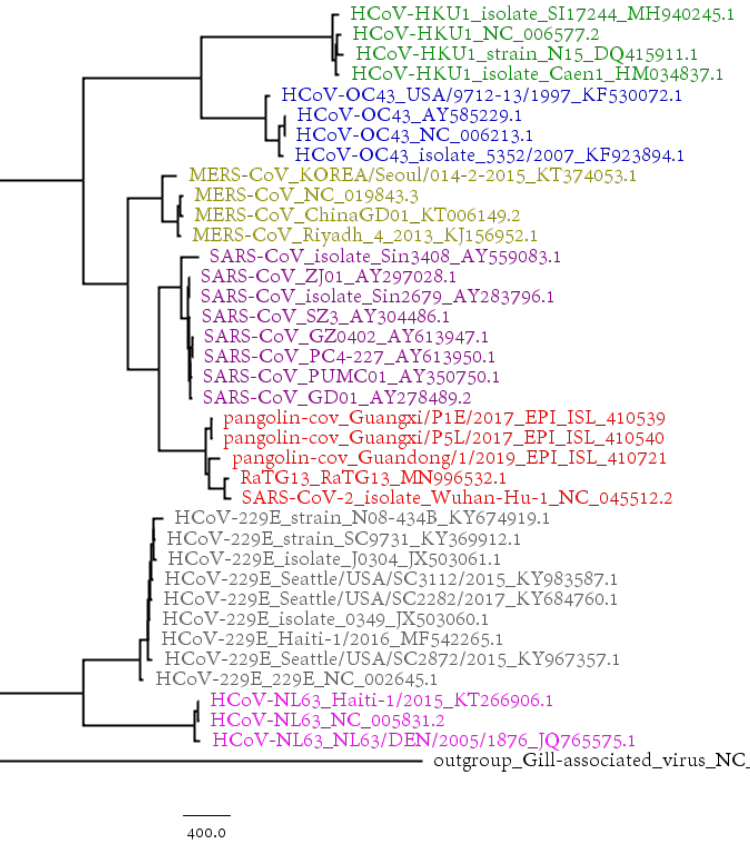
Figure 3. The phylogenetic tree of 38 coronavirus genomes based on BioNJ and Natural Vector algorithm. Table 1. The RMSD and NV distance between 3CL proteinase (6LU7) / spike protein (6VXX) of SARS-CoV-2 and the counterpart proteins of other human